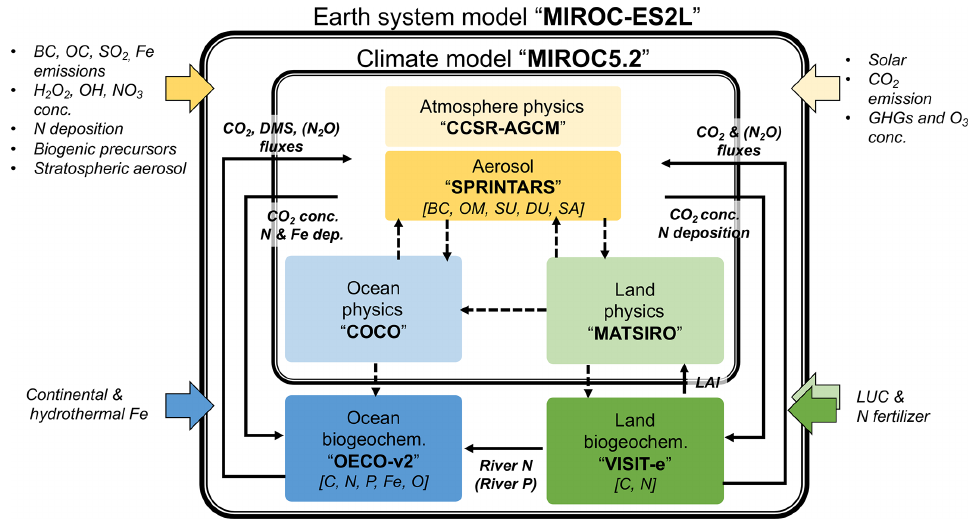
Figure 1. Schematic of component models in the new MIROC-ES2L Earth system model, the biogeochemical and biophysical interactions, and external forcing. The physical core of the model is MIROC5.2, which comprises an atmospheric climate model (CCSR-NIES AGCM or MIROC-AGCM) with an aerosol module (SPRINTARS), an ocean physical model (COCO) with a sea ice model, and a land physical model (MATSIRO) with a river submodel. The land biogeochemistry component (VISIT-e) simulates carbon and nitrogen cycles with an LUC submodel, and the ocean biogeochemistry component (OECO) simulates the cycles of carbon, nitrogen, iron, phosphorus, and oxygen. Color-boxed arrows indicate external forcing. Solid (dashed) black arrows represent biogeochemical (physical) variables exchanged between the component models (the exchanges of physical variables are almost the same as in MIROC-ESM; see Table 1 of Watanabe et al., 2011). Variables in square brackets represent the prognostic biogeochemical cycles and aerosol species (black carbon, BC; organic matter, OM; sulfate (including precursors), SU; dust, DU; sea salt, SA). The names of exchanged variables within parentheses are diagnosed variables, i.e., ocean–land riverine P flux diagnosed from the N flux and simulated land and ocean N 2 O fluxes used for diagnostic